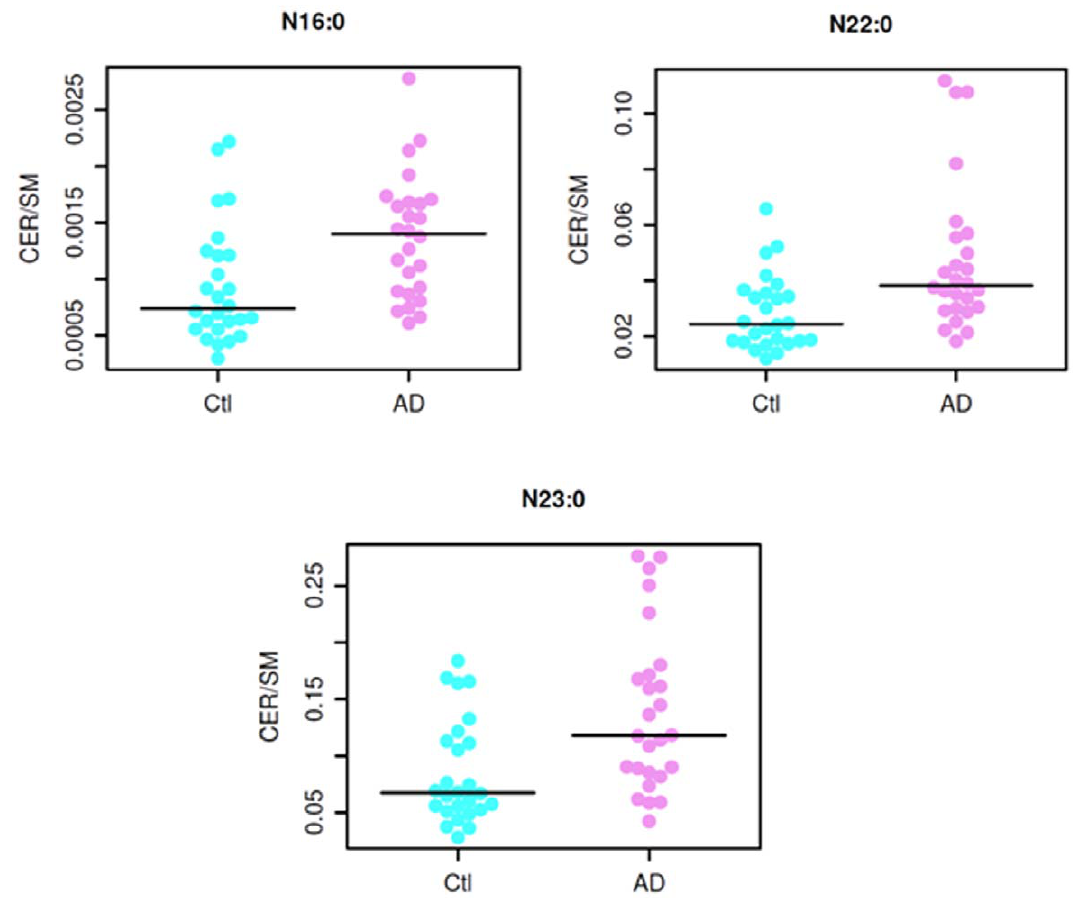
Figure 5. Ratios of specific ceramides to the sphingomyelins with the same fatty acid chains. See Table 5 for P values.